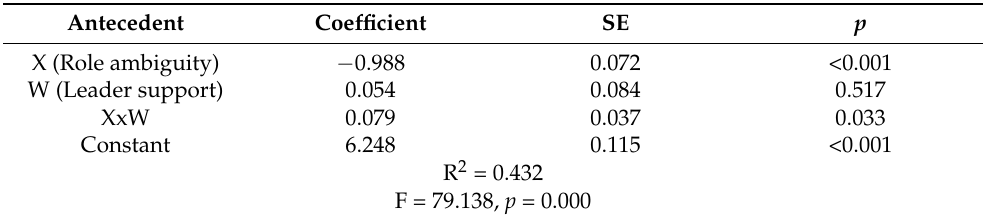
Table 5. Results of regression analysis examining the moderation of the influence of role ambiguity on employee engagement by leader